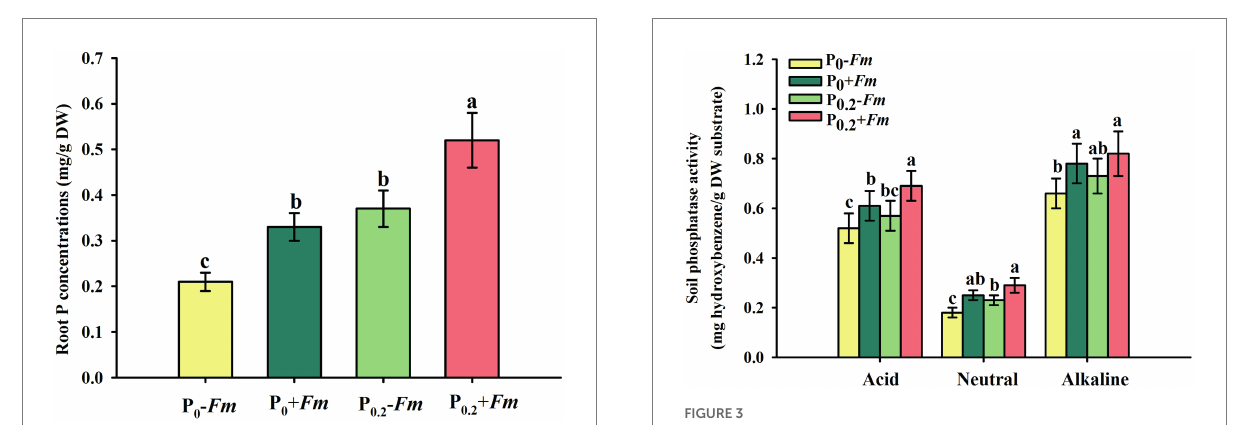
FIGURE 2 Changes in root P concentration of Polygonum cuspidatum by Funneliformis mosseae and P supply. Data (means ± SD, n = 4) followed by different letters above the bars indicate significant ( p < 0.05) differences among treatments. + Fm , inoculation with F. mosseae ; − Fm , inoculation without F . mosseae ; P 0 , 0 M P; P 0.2 , 0.2 M P; P, phosphorus.